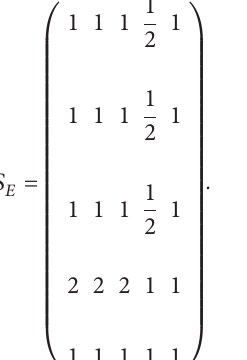
Table 7: Pairwise mean random consistency ratio of the com- parison matrix. Dimension ( n ) 1 2 3